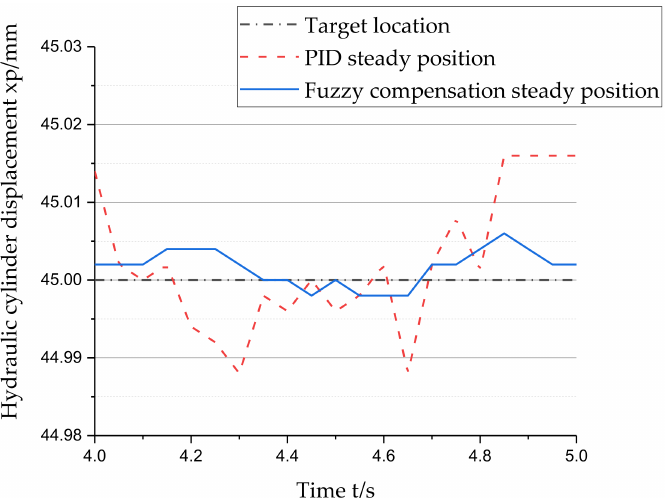
Figure 12. Local magnification curve of the retracted position of the hydraulic cylinder.